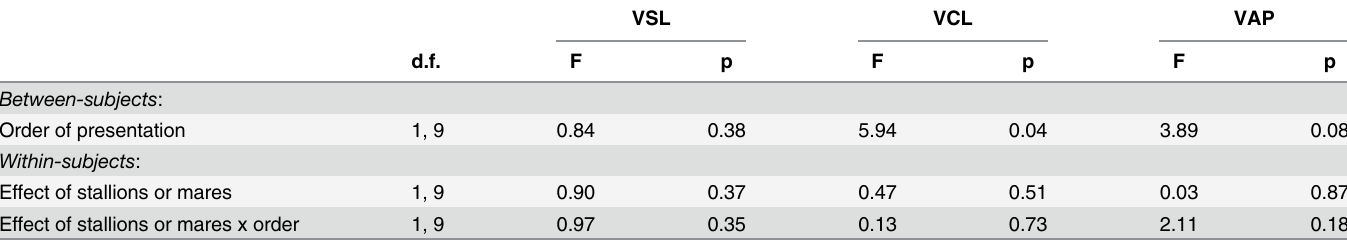
Table 2. MANOVA on the mean sperm velocity measures VSL (straight line velocity), VCL (curvilinear velocity), and VAP (average path velocity) after exposure to stallions or to mares.